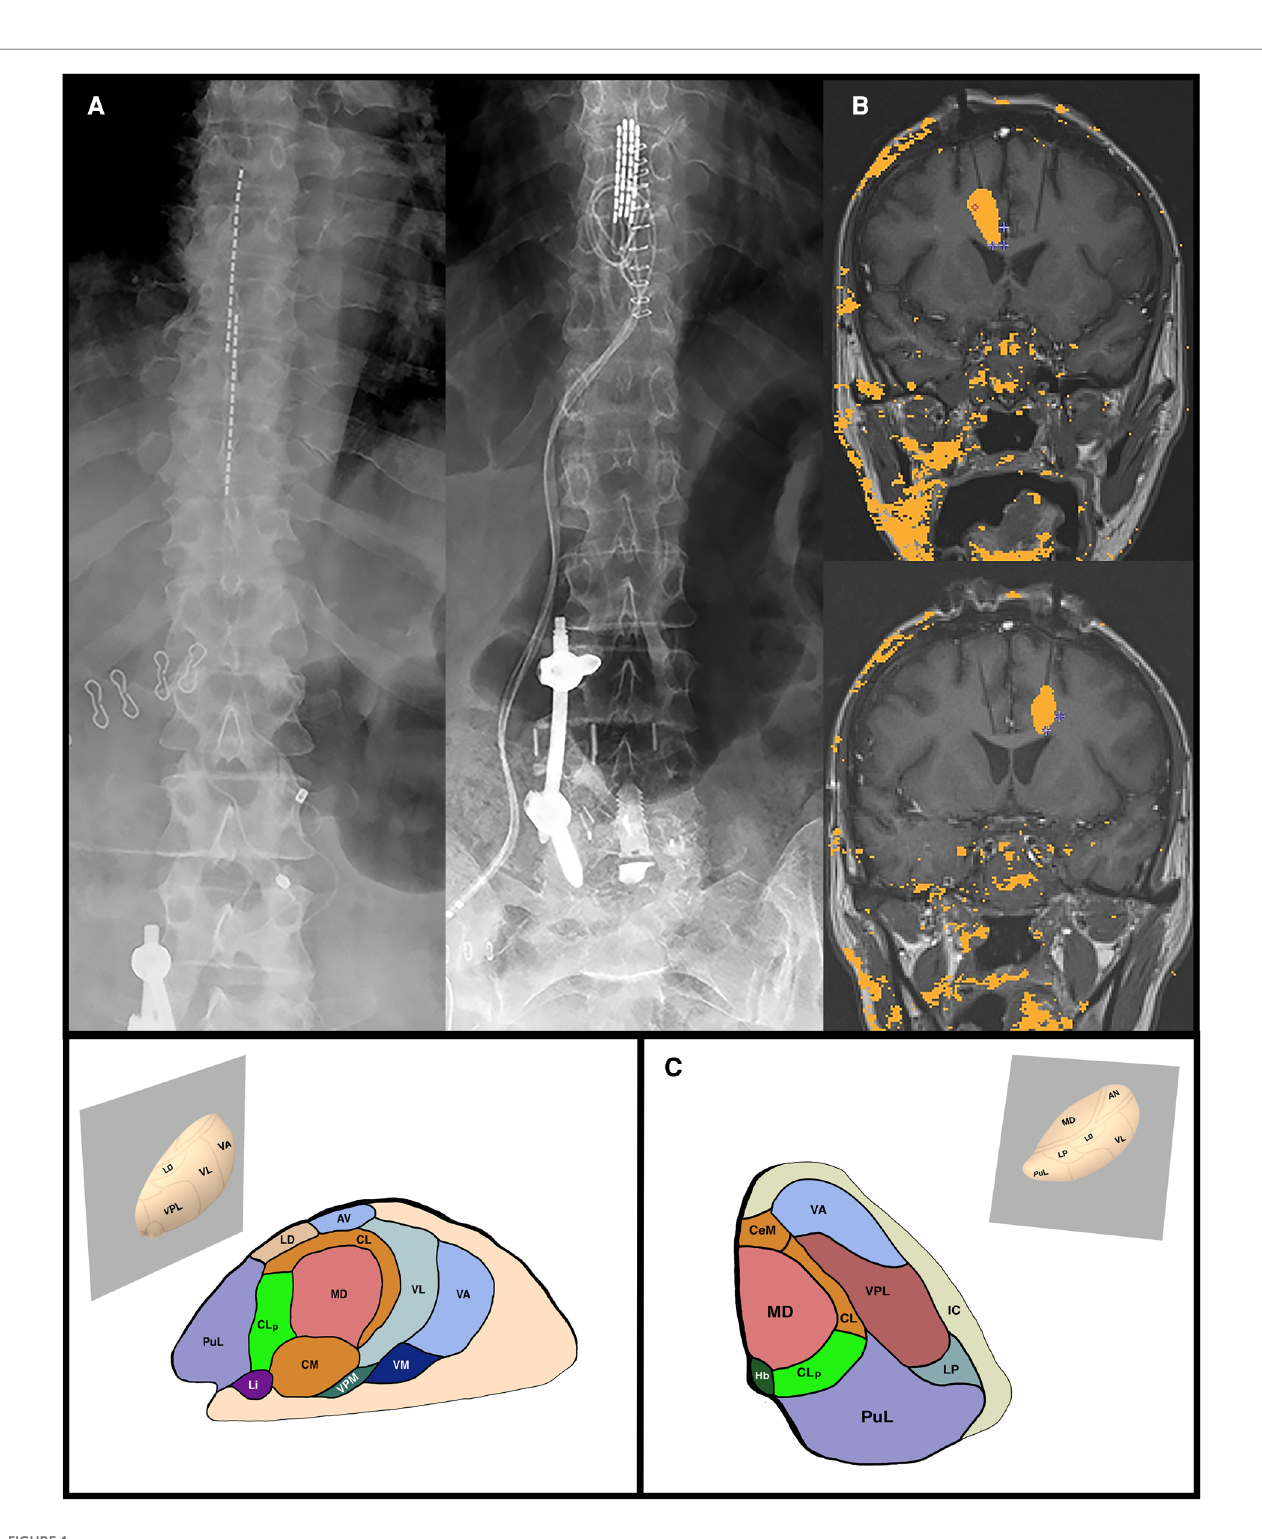
FIGURE 1 (A) Examples of percutaneous SCS leads (LEFT) and paddle SCS leads (RIGHT). (B) Intraoperative coronal MRI thermometry images of the completed right (TOP) and left (BOTTOM) anterior cingulotomy laser-induced thermal lesions. (C) Thalamic anatomy. Sagittal and Axial planes of the thalamus through the CLp. AV, anterior ventral nucleus; CM, centre median nucleus, CeM, central medial nucleus; CL, central lateral nucleus; CLp, posterior central lateral nucleus; Hb, habenular nucleus; LD, lateral dorsal nucleus; Li, limitans nucleus; LP, lateral posterior nucleus; MD, mediodorsal nucleus; PuL, pulvinar; VA, ventral anterior nucleus; VL, ventral lateral nucleus; VM, ventral medial nucleus; VPM, ventral posterior medial nucleus; VPL, ventral posterior lateral